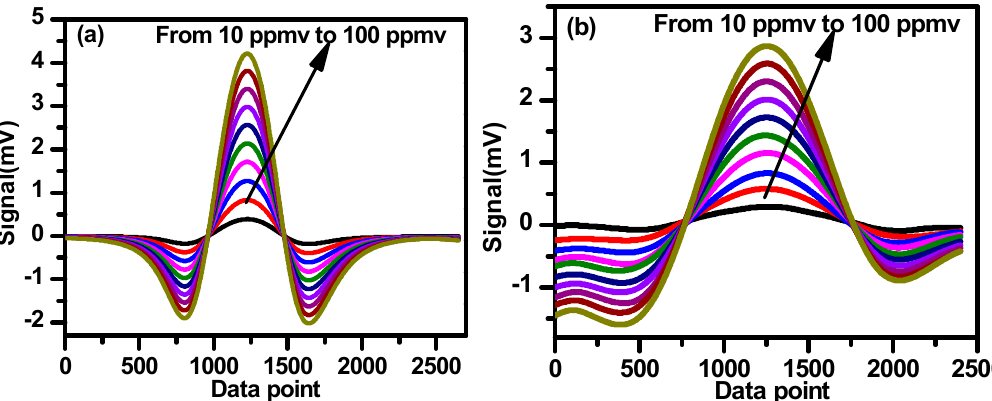
Figure 12. Second harmonic signals of CH 4 ( a ) and C 2 H 6 ( b ) at different concentrations ranging from 10 ppmv to 100 ppmv.